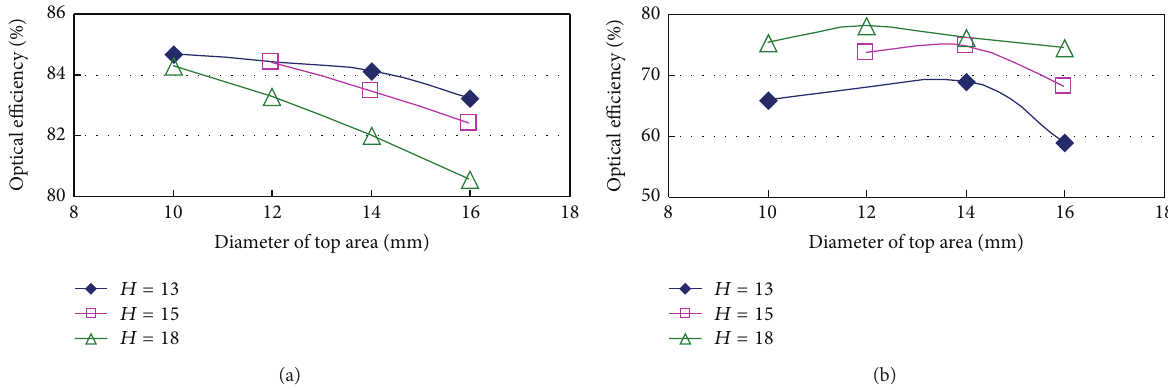
Figure 10: Effects of refractive cone SOE parameters (Phase II) on the optical efficiency: (a) incidence angle = 0 ∘ (normal incidence) and (b) incidence angle = 1 ∘ .